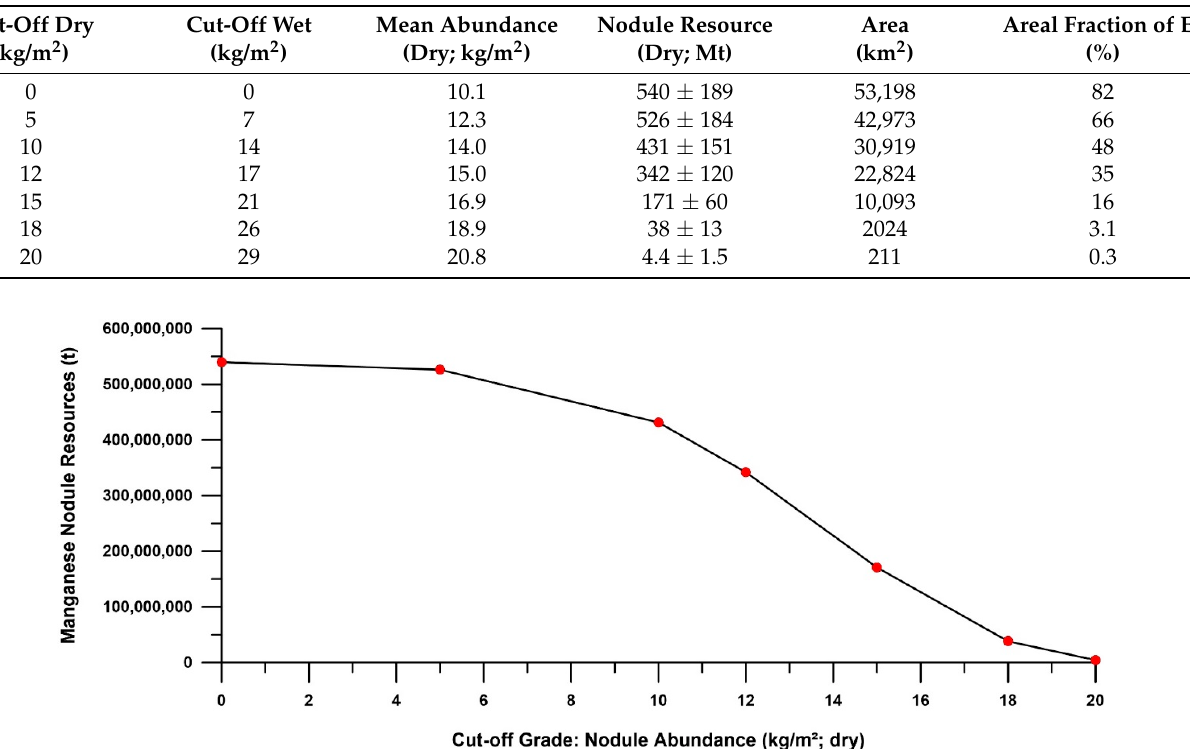
Figure 14. Plot of the predicted manganese nodule resource (dry weight) with different cut-off values for Area E1 based on the ANN model. There is a significant drop in resource quantity at a cut-off value of 10 kg/m 2 .